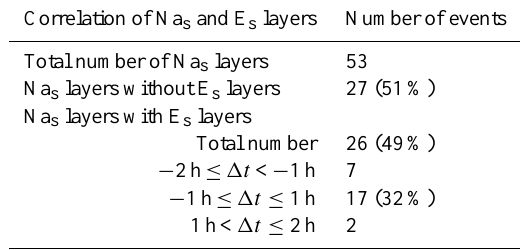
Table 3. The statistical correlation of Na s and E s layers over Qing- dao.